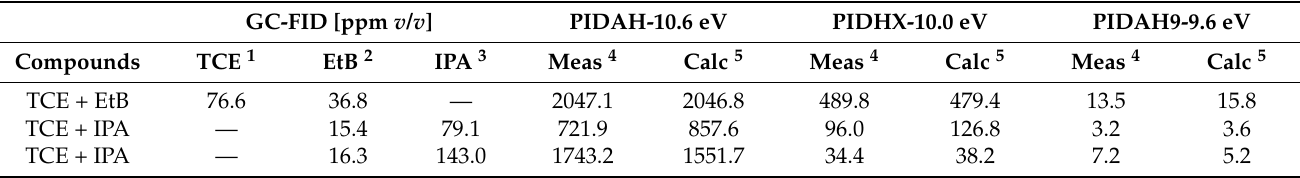
Table 7. Comparison of calculated and measured voltage responses—model